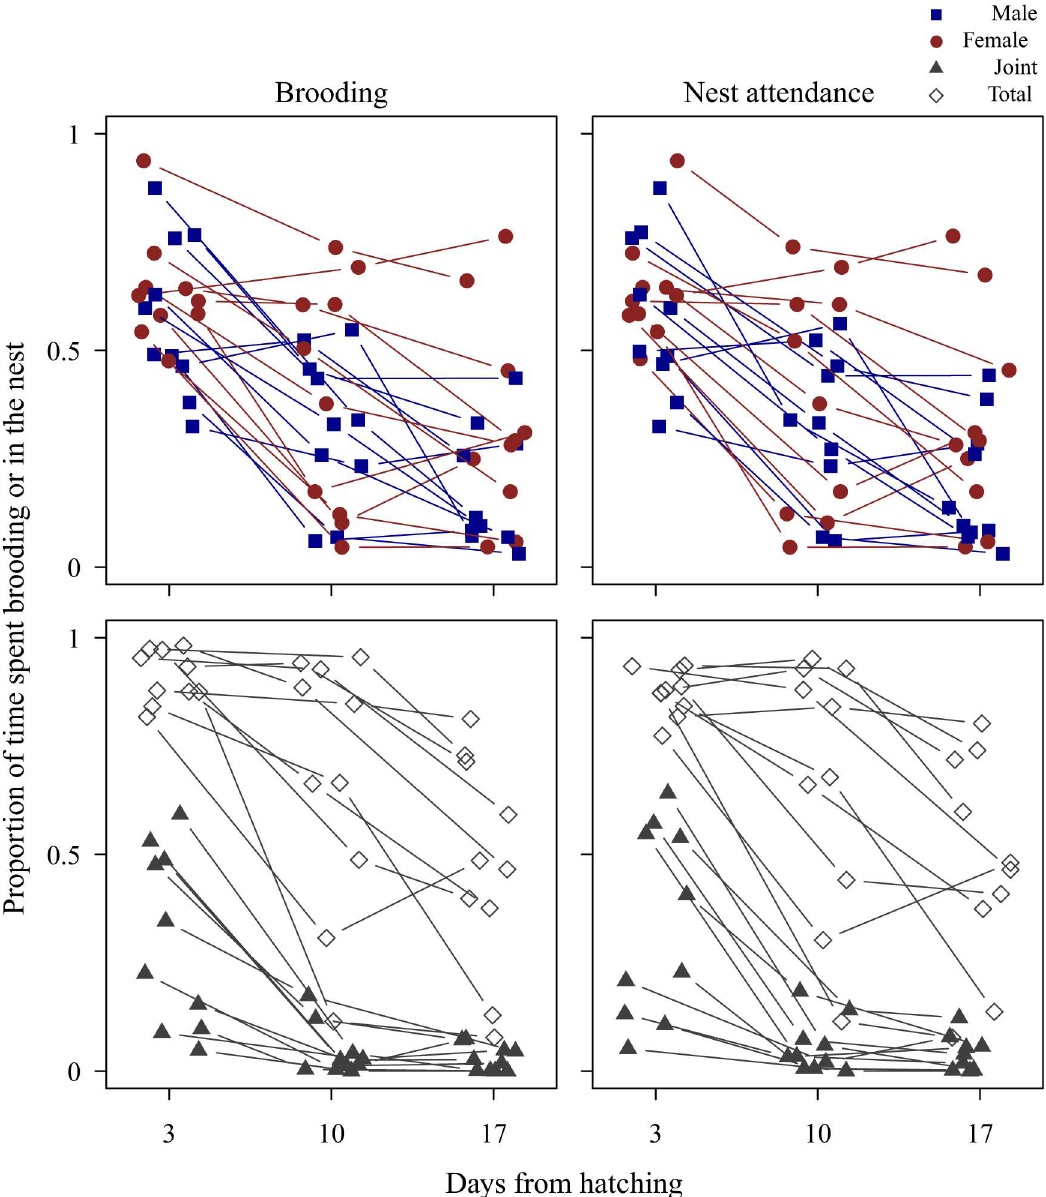
Fig 3. Division of labour and individual variation of parental effort in zebra finches during nestling provisioning. The figure shows proportionof 3h observation periods (10:00–13:00) spent broodingand inside the nest (nest attendance) during early, middle and late nestlingprovisioning (day 3, 10 and 17 post-hatching, respectively). Blue filled squaresrepresent male, red filled circles female, grey filled trianglesjoint (male and female simultaneous) and grey open diamondstotal parentaleffort (when at least one parent broods or attends the nest). Data from the same individualsare connectedwith